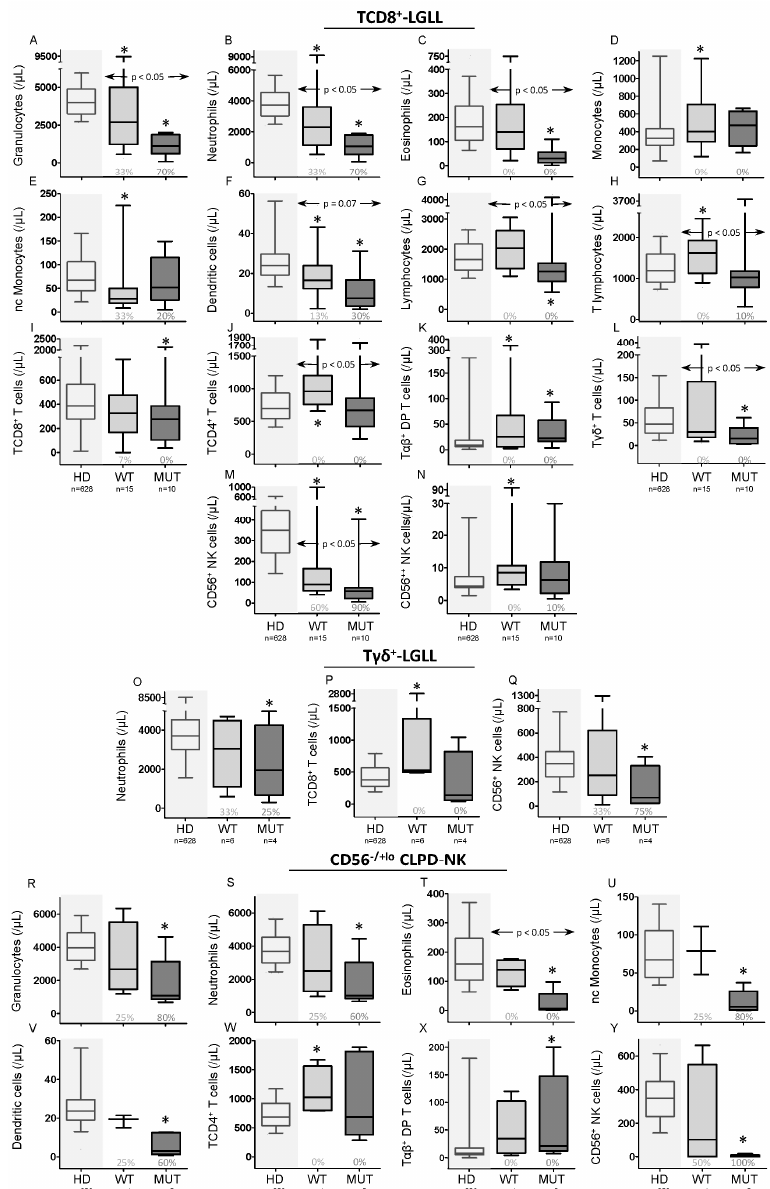
Figure 2. Distribution of normal peripheral blood (PB) leukocyte subsets in TCD8 + -LGLL, T γδ + -LGLL, and CLPD-NK patients classified according to their STAT3 mutational status. ( A – N ): distribution of normal residual leukocyte subpopulations found to be significantly ( p -value ≤ 0.05) different in PB in either WT ( n = 15) and/or STAT3 -mutated ( n = 10) TCD8 + -LGLL cases vs. age-matched HD ( n = 628), and between STAT3 WT and mutated TCD8 + -LGLL cases. ( O – Q ): distribution of normal residual leukocyte subpopulations found to be significantly ( p -value ≤ 0.05) different in PB of either WT ( n = 6) and/or STAT3 -mutated ( n = 4) T γδ + -LGLL cases vs. age-matched HD ( n = 628), or between STAT3 -WT and -mutated T γδ + -LGLL cases. ( R – Y ): distribution of normal residual leukocyte subpopulations found to be significantly ( p -value ≤ 0.05) different in PB of either WT ( n = 4) and/or STAT3 -mutated ( n = 5) CLPD-NK cases vs. age-matched HD ( n = 628), or between STAT3 -WT and -mutated CLPD-NK cases. In the above panels, notched boxes represent 25th and 75th percentile values; the lines in the middle correspond to median values (50th percentile) and vertical lines represent 10th and 90th percentile. The numbers under the boxes indicate the percentage of cases that showed cell counts below the minimum value found among HD. The horizontal arrows mean the p -value between WT and STAT3 -mutated cases. * p -value ≤ 0.05 vs. HD. Abbreviations (alphabetical order): HD, healthy donors; MUT, STAT3 -mutated; nc, nonclassical; p , p -value; WT,